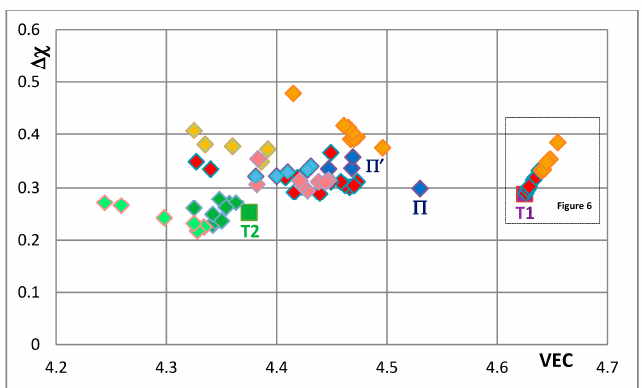
Figure 5. Δχ versus VEC map of all studied Nb 5 Si 3 that shows the effect of the substitution of Nb by Ti and Cr and Si by Al, B, Sn or Ge on the position of the silicide in the map. The unalloyed Nb 5 Si 3 (T1) and the Nb 5 (Si,B) 3 (T2) silicides are shown respectively by the purple and green squares. The symbol Π is for the (Nb,Ti) 5 Si 3 . Silicides where Si is substituted by B, Ge and Sn are shown by dark green, dark gold and dark red diamonds, respectively. Silicides where Si is substituted by Al and B or Ge or Sn are shown by lighter green, lighter gold and lighter red diamonds, respectively. Silicides that do not contain B or Ge or Sn are shown by dark blue diamonds. Silicides where Si is substituted by Al but not B, Ge or Sn are shown by lighter blue diamonds. For inset see Figure 6. For the data represented by Π and Π ’ see text.